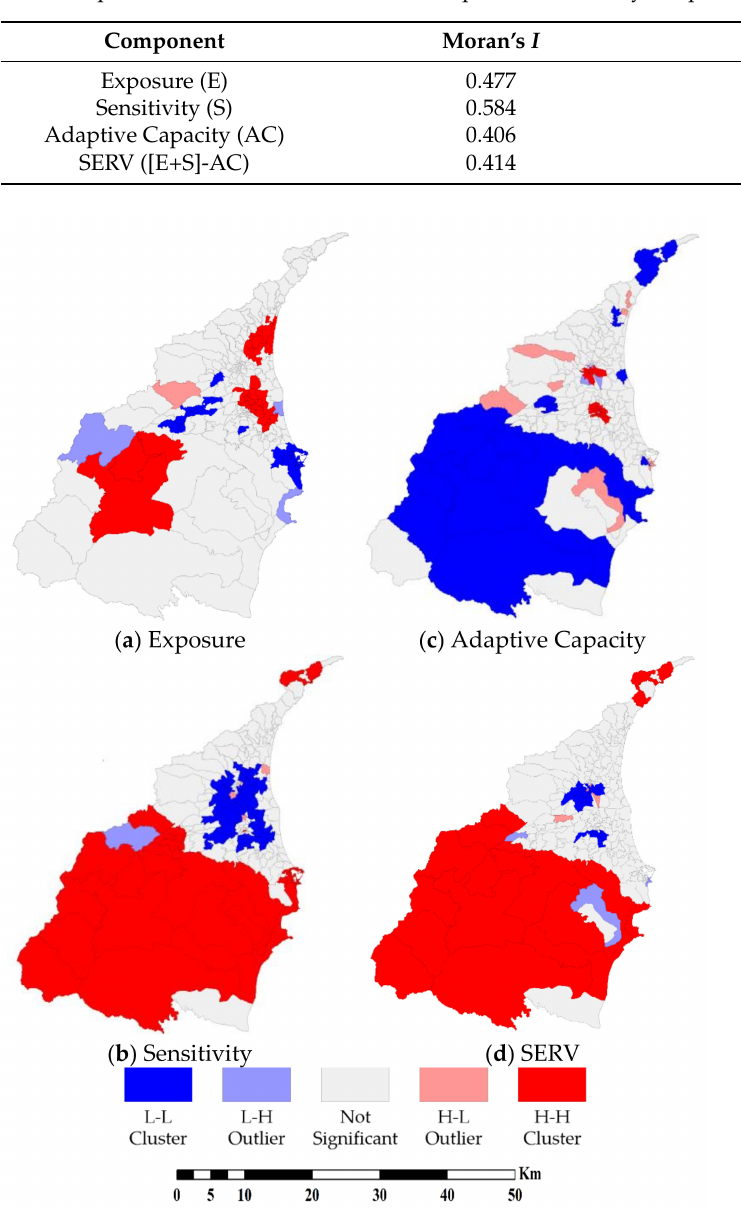
Table 5. Spatial autocorrelation result of the exposure, sensitivity, adaptive capacity, and SERV.